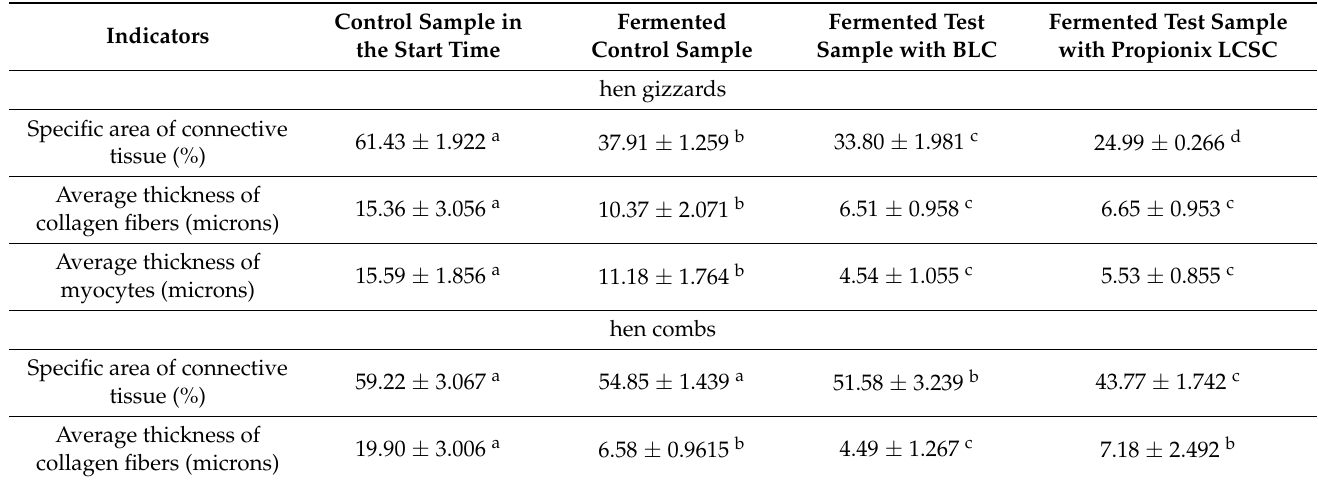
Table 1. Results of morphometric analysis of fermented hen